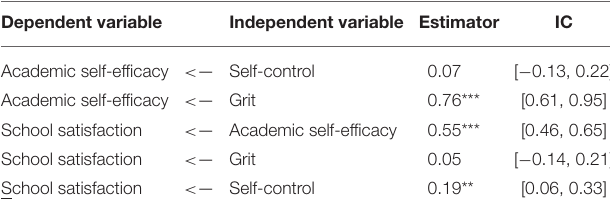
TABLE 4 | Indirect effects of the structural equation model for primary students. Dependent